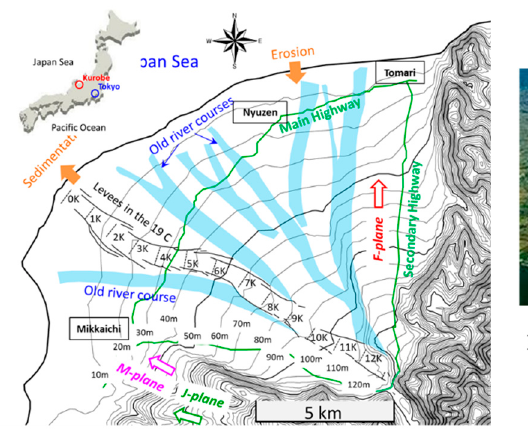
Figure 1. Kurobe Alluvial Fan.